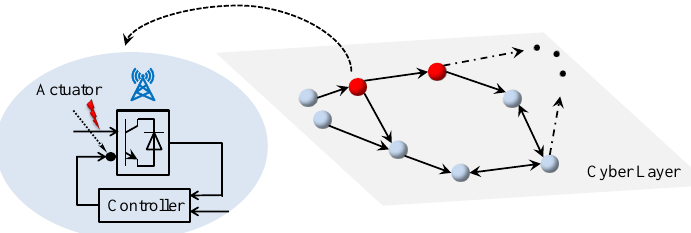
Figure 1. A networked multi-inverter system under actuator